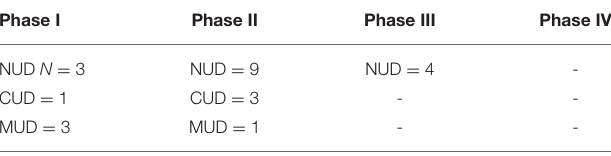
TABLE 2 | Synthetic presentation of clinical trials for immune therapy in SUDs. Phase